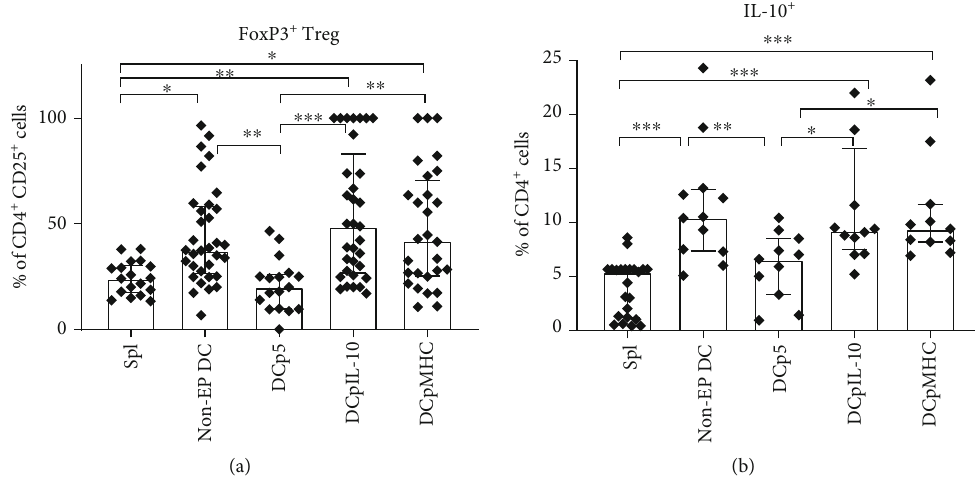
Figure 3: Tolerogenic properties of the obtained DCs. Induction of (a) CD4 + CD25 + FoxP3 + Tregs and (b) IL-10-producing CD4 + T cells by the di ff erent DC groups in C57BL/6 mouse splenocyte cultures. (a) N = 23 per group, (b) N = 10 per group. Data are presented as median and interquartile range. Brackets indicate signi fi cant di ff erences (the Kruskal-Wallis test with Dunn ’ s corrected multiple comparisons, ∗ P < 0 : 05 , ∗∗ P < 0 : 01 , and ∗∗∗ P < 0 : 001 ). Spl: C57Bl/6 splenocytes cultured without adding DCs; non-EP DCs: C57Bl/6 splenocytes cocultured with nonelectroporated DCs; DCp5: C57Bl/6 splenocytes cocultured with DCs electroporated with p5; DCpIL-10: C57Bl/6 splenocytes cocultured with DCs electroporated with pIL-10; DCpMHC: C57Bl/6 splenocytes cocultured with DCs electroporated with